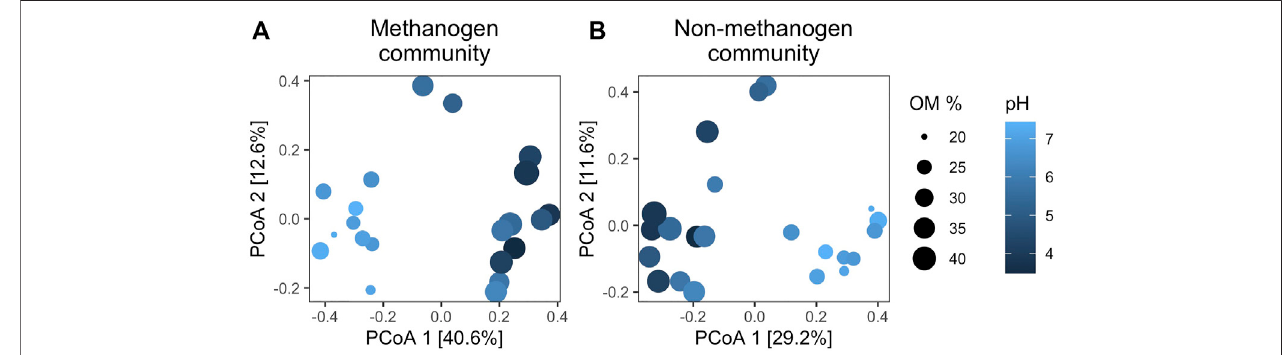
FIGURE 1 | First two principal coordinates of the methanogen community composition (A) and the non-methanogen community composition (B) . Permutational analysis of variance indicated that methanogen community composition was signi fi cantly related to pH (F 22,1 = 9.24, p = 0.001) and sediment organic matter content (F 22,1 = 8.58, p = 0.001). Similarly, non-methanogen community composition was also signi fi cantly related to (F 22,1 = 5.77, p = 0.001) and sediment organic matter content (F 22,1 = 6.01, p =